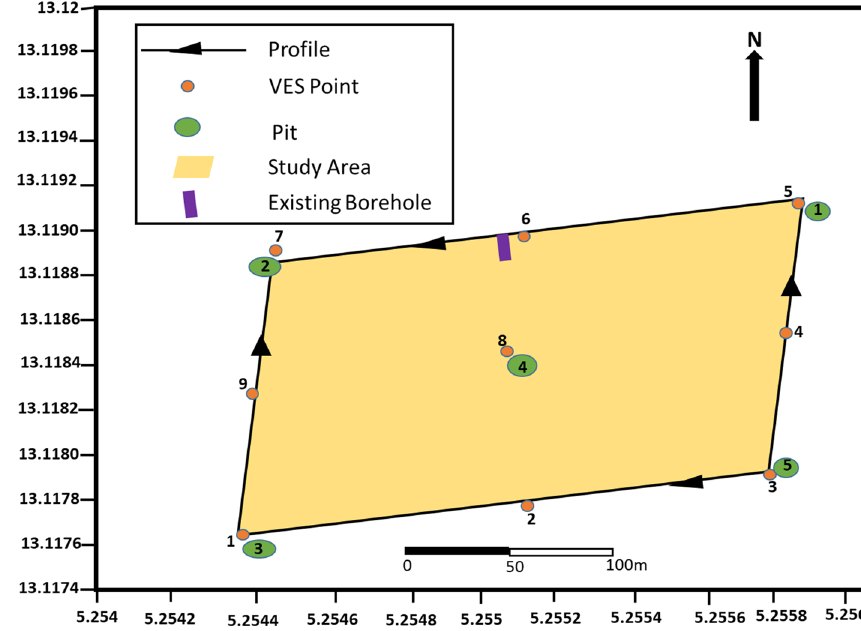
Fig. 3 Location map showing profile lines, VES points, pits and existing borehole